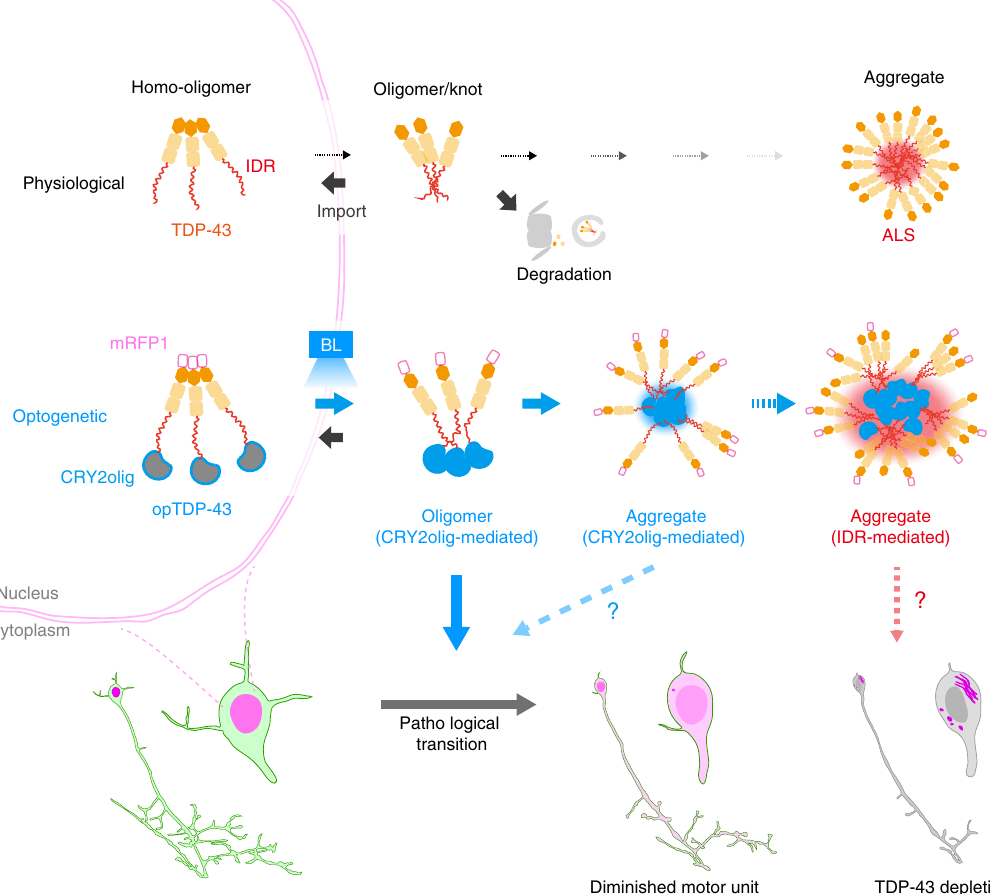
Fig. 8 Sequentially regulated illumination-triggered TDP-43 knot and aggregate formation. In physiological conditions, TDP-43 forms oligomers via its N-terminus and is primarily localized in the nucleus. Spinal motor neurons keep the cytoplasmic concentration of TDP-43 oligomers at a low level to prevent them from turning into toxic irreversible oligomers mediated by the C-terminus IDRs (toxic “ knots ” ), which possess competence for developing into pathological TDP-43 aggregates, a hallmark of ALS. CRY2olig-driven opTDP-43 oligomerization promotes pathological change of the motor neurons, such as axon retraction associated with myo fi ber denervation, prior to accumulation of distinct cytoplasmic aggregates. Whether CRY2olig-diriven opTDP- 43 aggregates are toxic to motor neurons and whether CRY2olig-diriven aggregates eventually deplete endogenous nuclear TDP-43 pools are Rescue of TDP-43 knockout fi sh via mRNA injection . For the expression of human and zebra fi sh TDP-43 and its derivatives via mRNA injection, the open reading frames of zebra fi sh tardbp (TDP-43z), zebra fi sh-codon optimized human TDP-43 (TDP-43h), mRFP1-tagged zebra fi sh tardbp (mRFP1-TDP-43z) and opTDP-43z was cloned into pCS2 + vector in vitro-transcribed with mMESSAGE mMACHINE Kit. First, we injected varied amount of TDP-43z mRNA into the offspring obtained from incrosses of parental zebra fi sh carrying homozygous tardbp-n115 and heterozygous tardbpl-n94 mutation or heterozygous tardbp-n115 and homozygous tardbpl-n94 mutation at the one cell stage. After investigating the presence or absence of blood fl ow at 36 – 48 hpf, all fi sh were subjected individually to genotyping for tardbp-n115 and tardbpl-n94 alleles. The uninjected tardbp-n115 tardbpl-n94 double homozygotes displayed a swollen heart that was beating, but the blood cells were completely stacked on the yolk surface and cannot reach the heart. An injection of 300 ng of TDP-43z mRNA was the most effect effective in Throughout the assay, we scored that the blood fl ow was “ rescued ” when any blood cell fl owing through the beating heart was observed. The function of TDP-43h and TDP-43 derivatives were tested by the microinjection of 300 ng mRNA each. The tardbpl-n115 allele was identi fi ed by performing Heteroduplex Mobility Assay (HMA) against PCR product obtained with a primer pair: tardbp-6F3 (5 ′ -gcc aga taa taa gag gaa gat gga-3 ′ ) and tardbpl-6R3 (5 ′ -tga cag tac aaa gac aaa cac cac-3 ′ ). The tardbpl-n94 allele was similarity identi fi ed by using a primer pair: tardbpl-4F2 (5 ′ -caa tca ctg aat gaa tgc act ttt-3 ′ ) and tardbpl-4R2 (5 ′ -gtt tgc tta tac taa cct gca cca-3 ′ ). Blue light illumination . Short-term (<4h) light stimulations of mRFP1-CRY2olig and opTDP-43z were carried out by embedding fi sh in the 0.8 – 1% low-melting